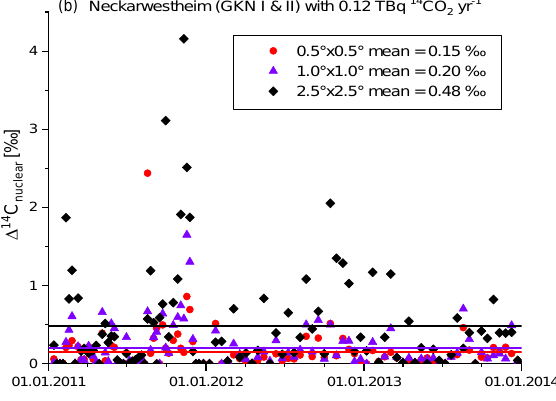
Figure 5. (a) Results of (cid:49) 14 CO 2 measurements in Heidelberg (un- corrected); (b) nuclear contribution from all installations in Heidel- berg (note expanded (cid:49) 14 C